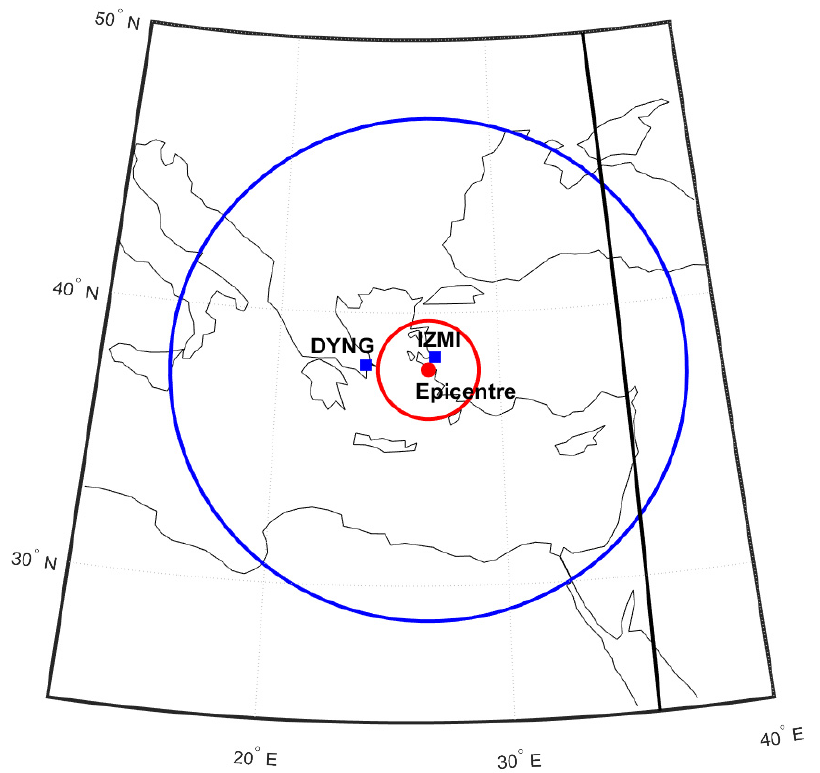
Figure 1. The locations of GPS-IGS stations DYNG and IZMI (blue squares), the EQ epicenter (red disk) and the EPZ (blue circle), CZ (red circle), and Swarm satellite track (black